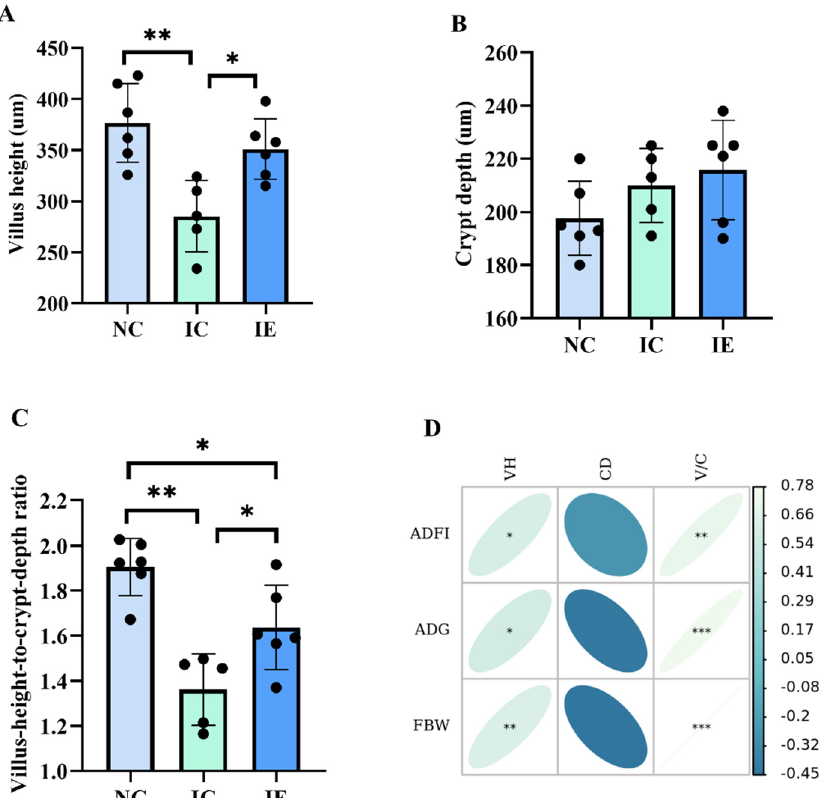
Figure 1. Effects of EGF on the jejunum morphology of piglets with IUGR. ( A ) villus height, ( B ) crypt depth, ( C ) villus height to crypt depth, ( D ) correlations analysis between intestinal morphology and growth performance. Values are expressed as means ± SEM, n = 6 (one pig in the IC group was dead, n = 5 in IC group); NC: NBW piglets fed with basal diet; IC: IUGR piglets fed with basal diet; IE: IUGR piglets fed with basal diet supplemented with 2 mg/kg EGF. * p < 0.05, ** p < 0.01, *** p < 0.001.